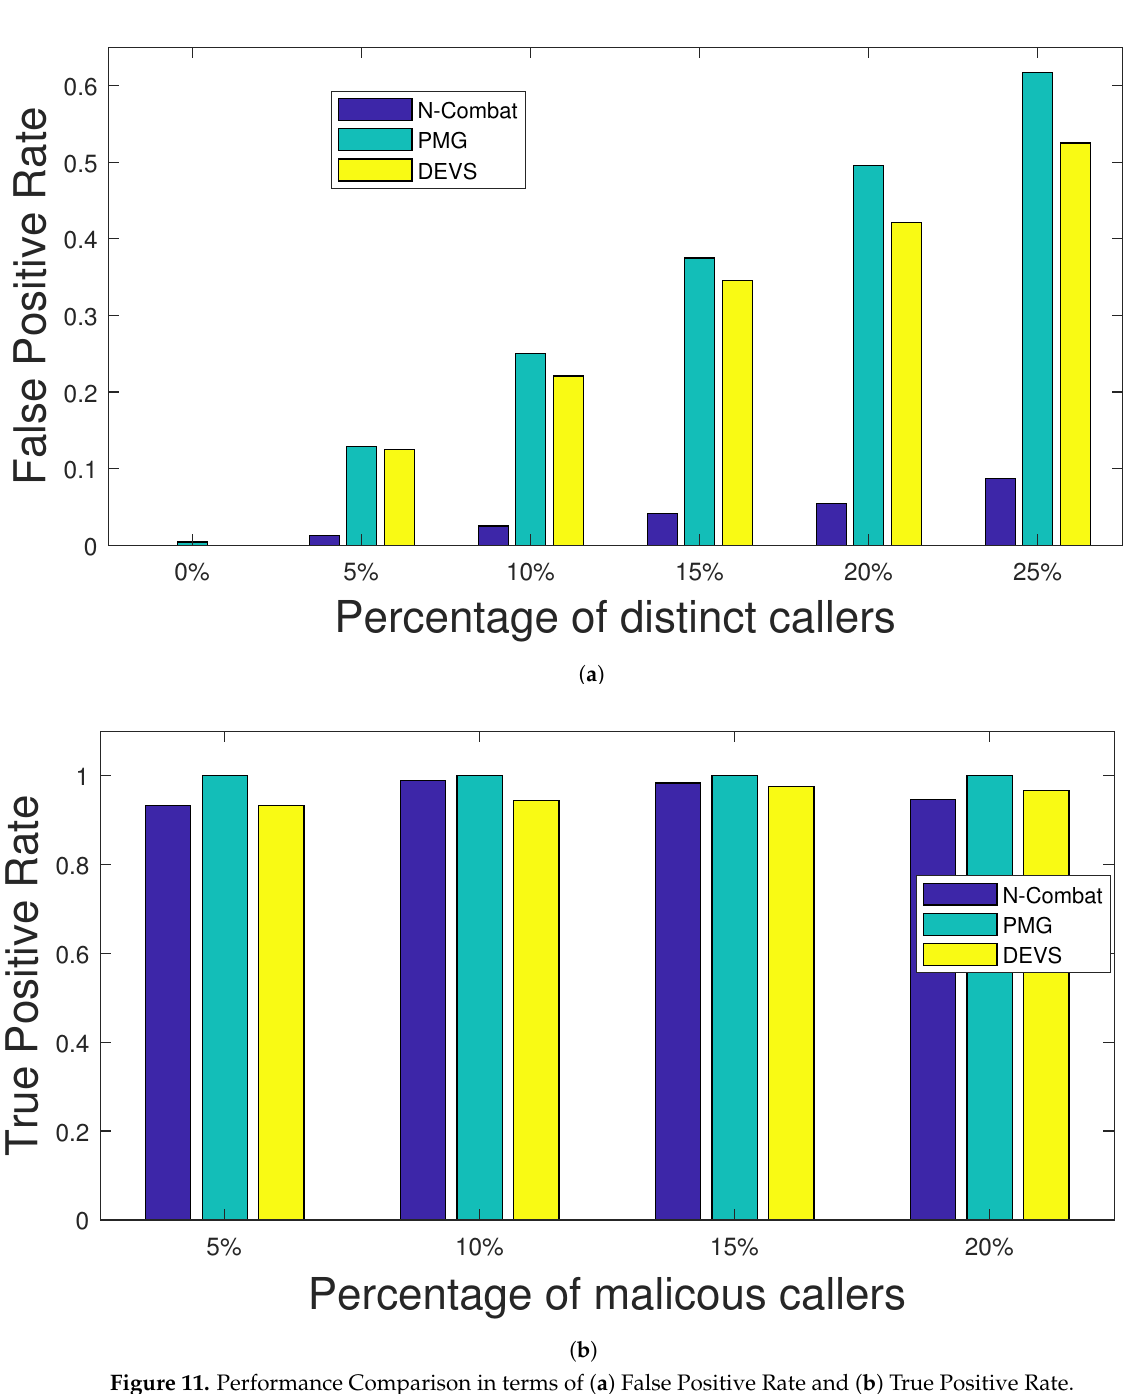
Figure 11. Performance Comparison in terms of ( a ) False Positive Rate and ( b ) True Positive